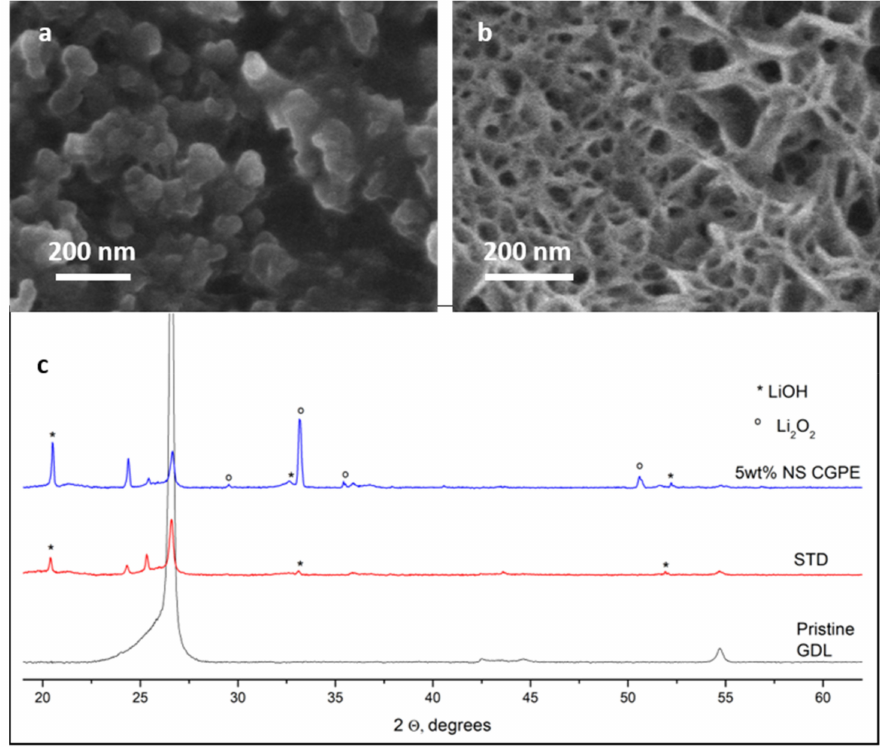
Figure 7. FESEM micrographs of the cathode surfaces after 10 cycles for the STD cell ( a ) and the 5 wt% NS CGPE cell ( b ). XRD patterns of a pristine cathode, the STD cathode and the 5 wt% NS CGPE cathode after 10 cycles (ICCD database: Li 2 O 2 [00-009-0355] and LiOH [00-004-0708]) ( c